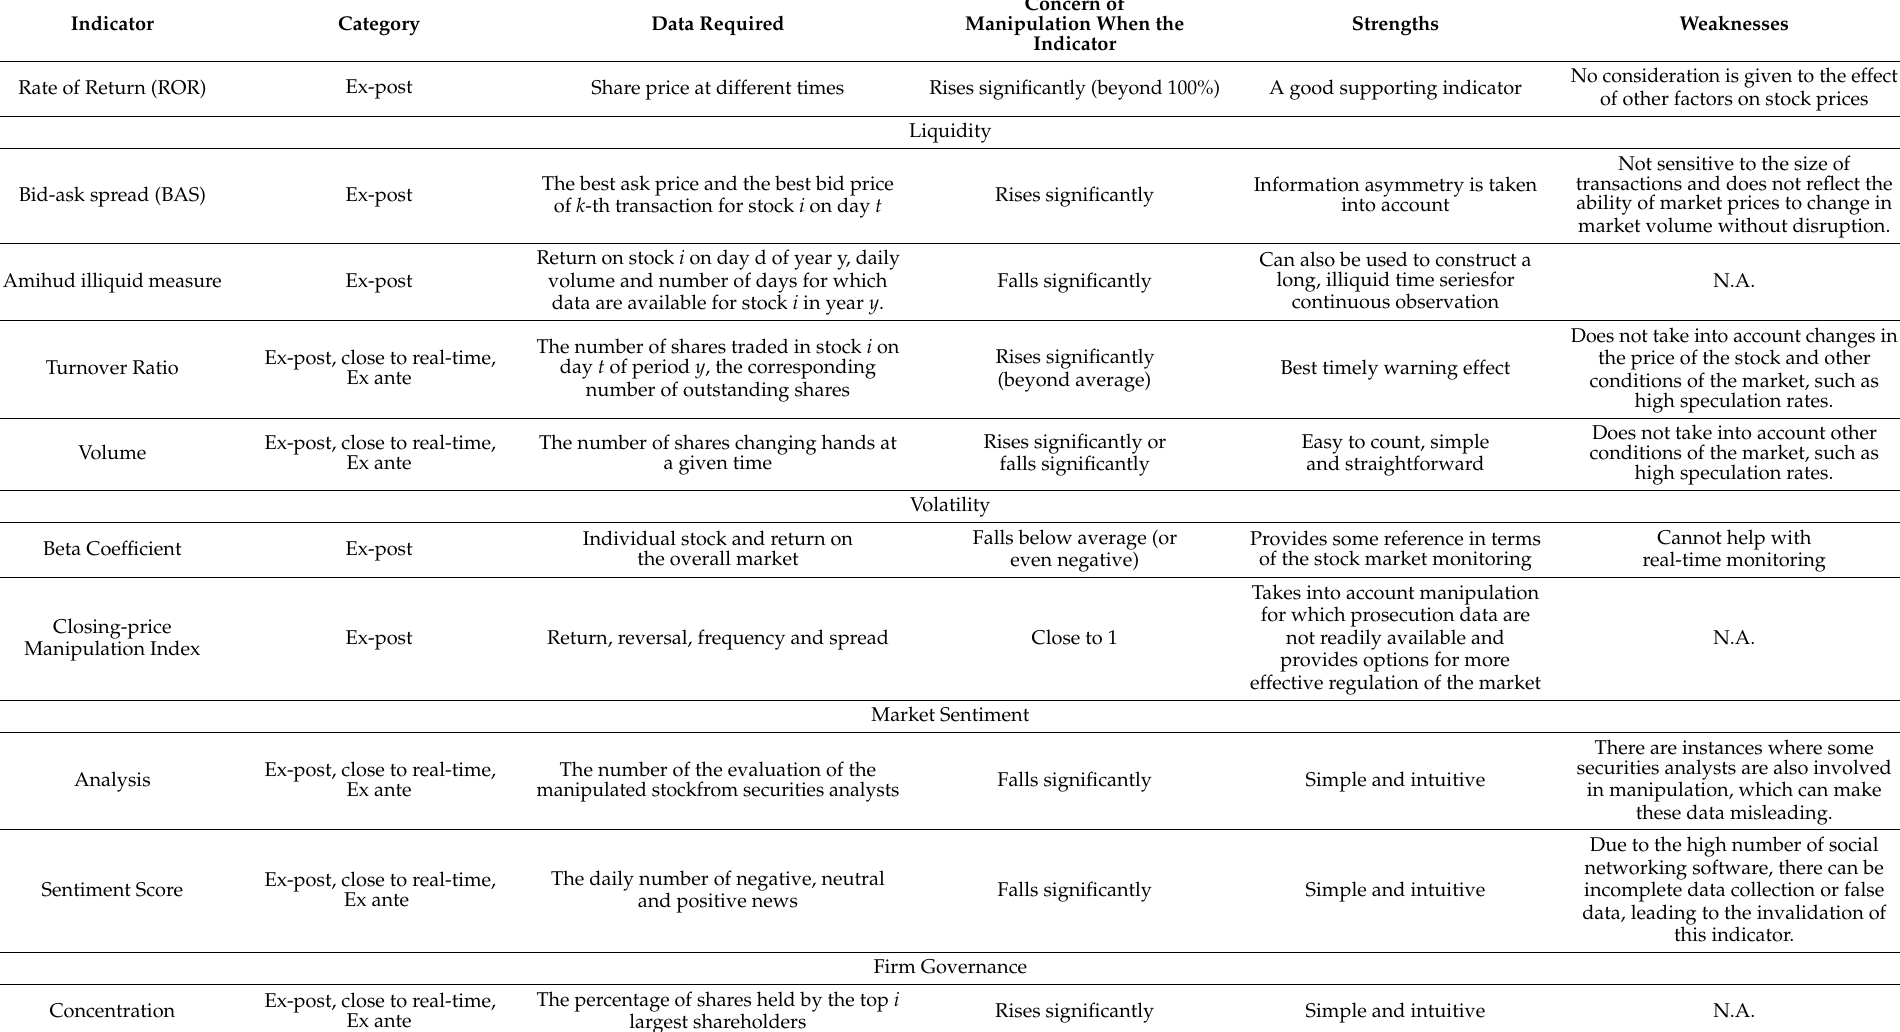
Table 3. Summary of power market monitoring